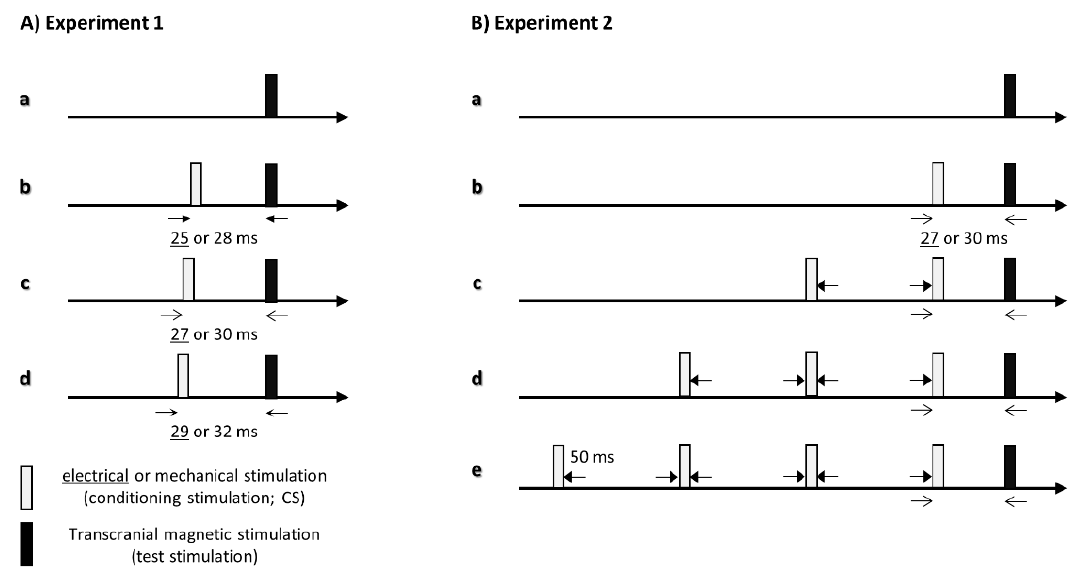
Figure 1. Schematic representation of somatosensory stimulation and transcranial magnetic stimulation (TMS). ( A ) Paradigm of experiment 1. Motor evoked potentials were measured by TMS alone (Aa: single), electrical stimulation conditions (Ab: ISI, 25 ms; Ac: ISI, 27 ms; Ad: ISI, 29 ms) and mechanical tactile stimulation conditions (Ab: ISI, 28 ms; Ac: ISI, 30 ms; Ad: ISI, 32 ms). ( B ) Paradigm of experiment 2. Motor evoked potentials were measured by TMS alone (Ba: single) and four different numbers of repetitions (Bb: 1 stim; Bc: 2 stim; Bd: 3 stim; Be: 4 stim) of each somatosensory stimulation; the interstimulus interval between the somatosensory stimulation and TMS was set to 27 ms (electrical stimulation) and 30 ms (mechanical tactile stimulation).